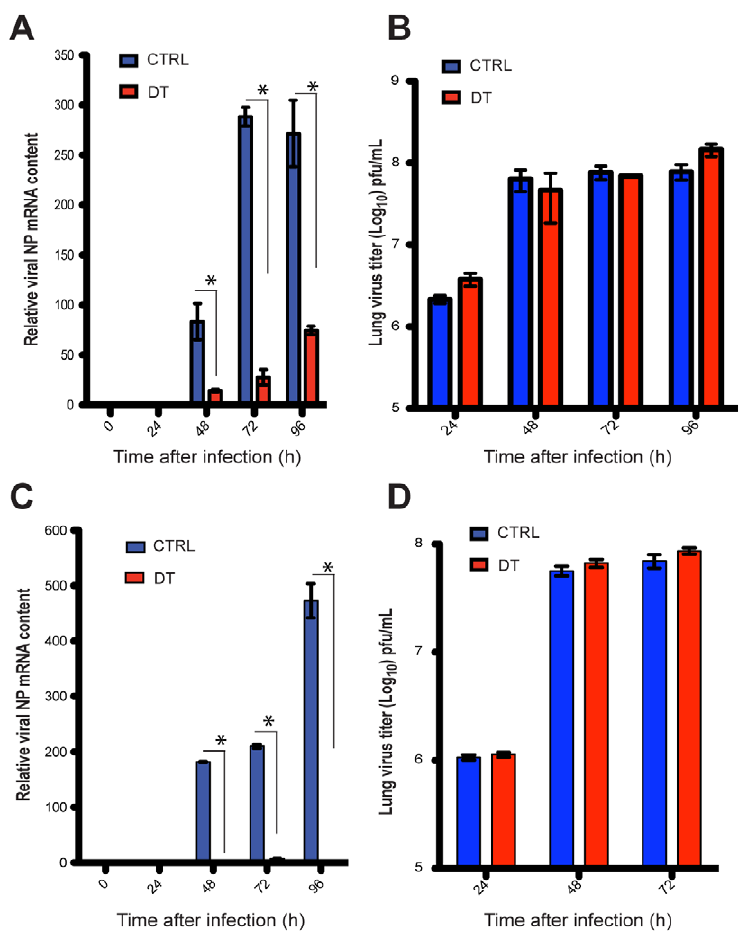
Figure 4. Depletion of total DCs or Langerin + DCs compromises viral load in the MLNs during infection. A. Langerin-DTR-EGFP mice were injected i.p with DT daily, starting one day before infection with PR8. MLNs were harvested and NP mRNA was quantitated by qPCR. B. Lung virus titers of DT-treated PR8 infected Langerin-DTR-EGFP mice (red bars) or mock treated (blue bars). C and D. CD11c-DTR-EGFP mice were used instead, performing the same experiments as described in A and B. Error bars represent mean + /- SD, * p ,